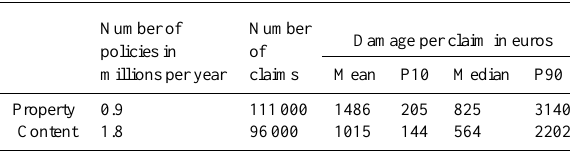
Table 2. Key characteristics of insurance databases held by the Dutch Association of Insurers for the period